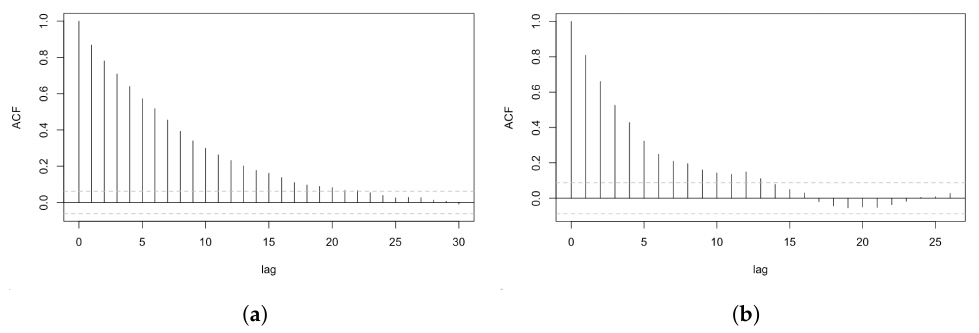
Figure 5. Autocorrelation plots, ( a ) autocorrelation plot for θ 4 , ( b ) autocorrelation plot for b 2